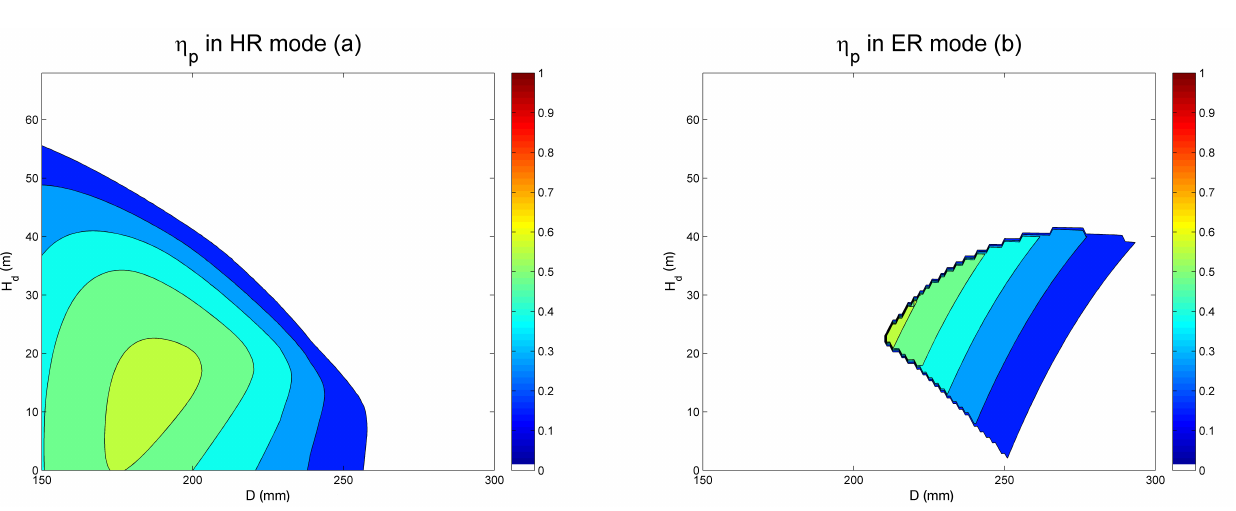
Figure 3. η values resulting from the Variable Operating Strategy (VOS): ( a ) HR mode; p and ( b ) ER